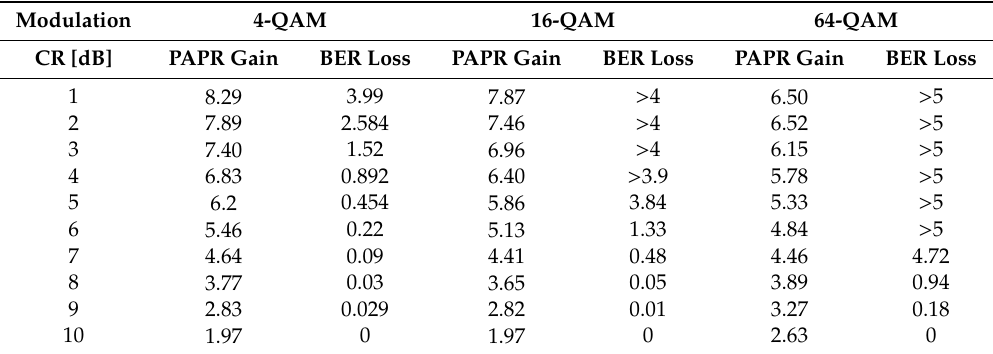
Table 3. Gain in PAPR at CCDF = 10 − 4 and BER loss at = 10 − 3 when β = 5 with variable CR and modulation